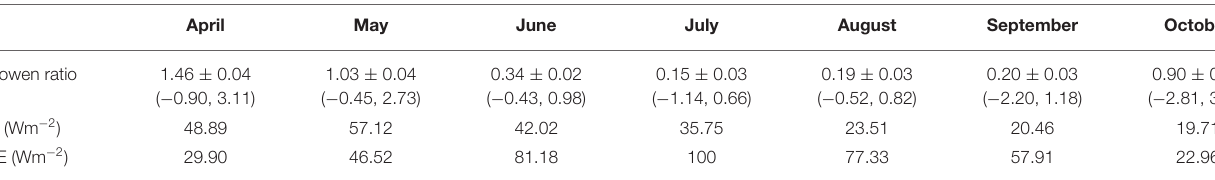
TABLE 2 | Energy balance at the open fen.